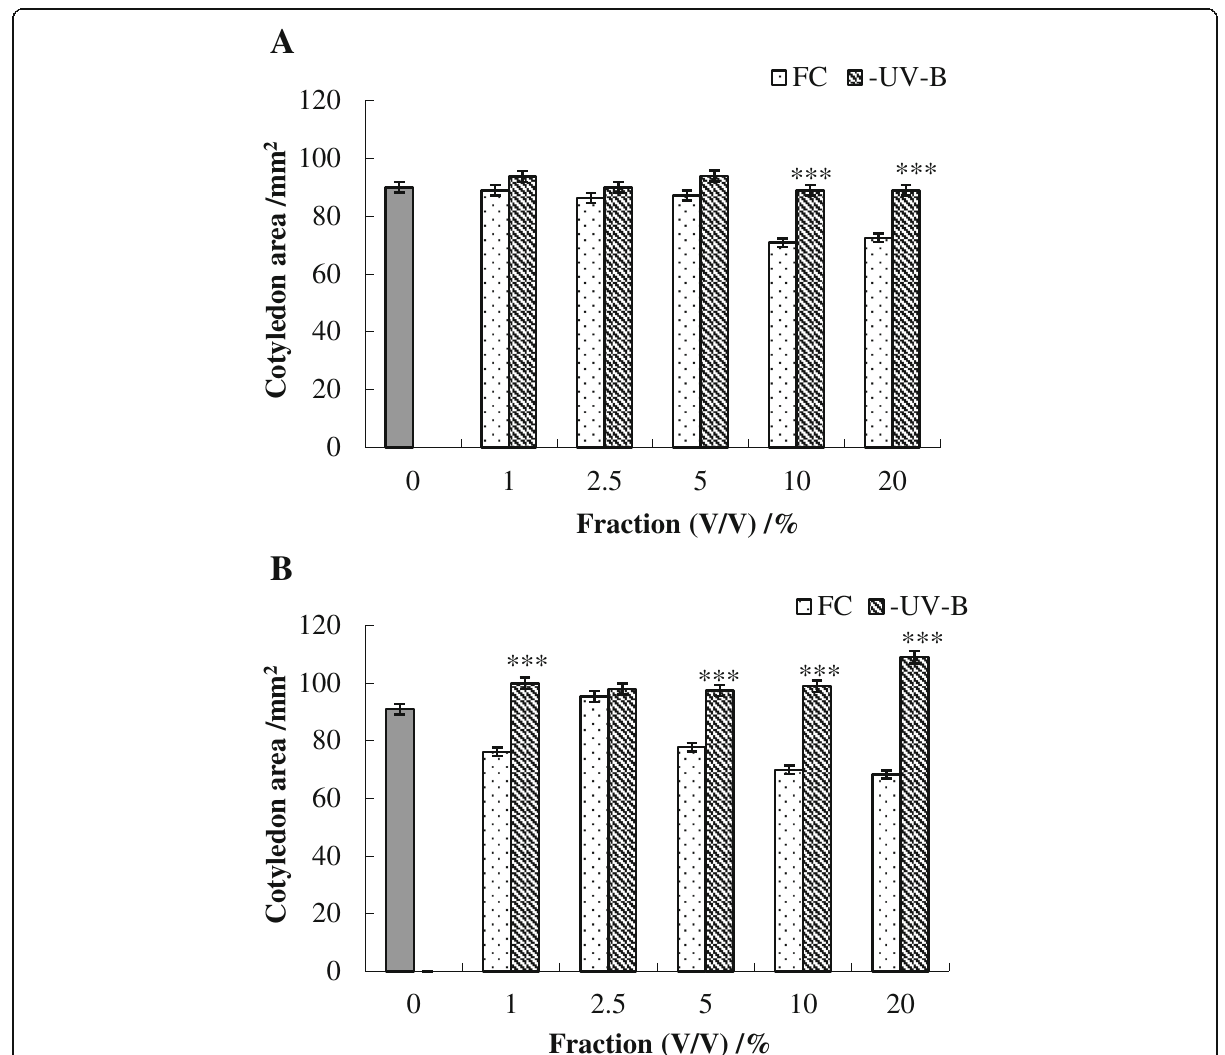
Fig. 9 Effect of ethyl acetate fraction obtained from leaves extracts of cotton var. Vikram on cucumber cotyledons expansion in dark ( a ) and in light ( b ). The gray solid column indicates expansion growth of cucumber cotyledons grown in distilled water. The vertical bar indicates ±SE for mean. Values are significantly different at * P <0.05, ** P <0.01, *** P <0.001 from filter